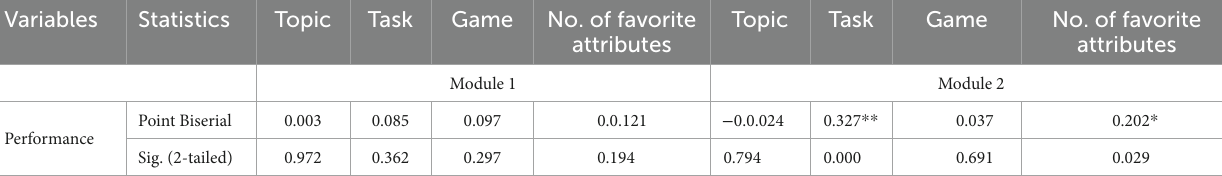
TABLE 5 Point biserial correlation result of the least favorite module